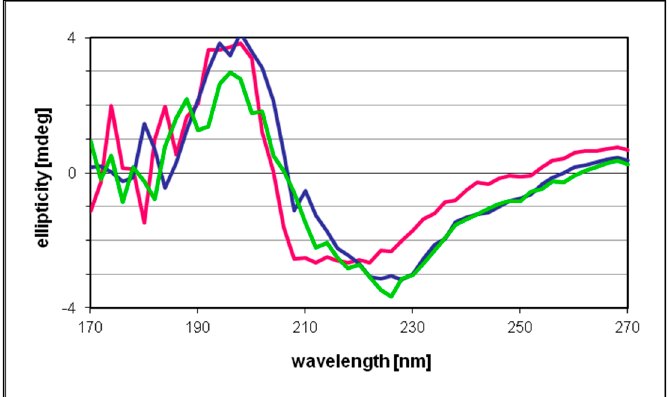
Figure 8. Circular dichroism spectrum recorded for a TADH sample before (pink line) and after 24 h at 30 °C (dark blue line), and after 24 h at 30° C in the presence of Pd NPs (green line).